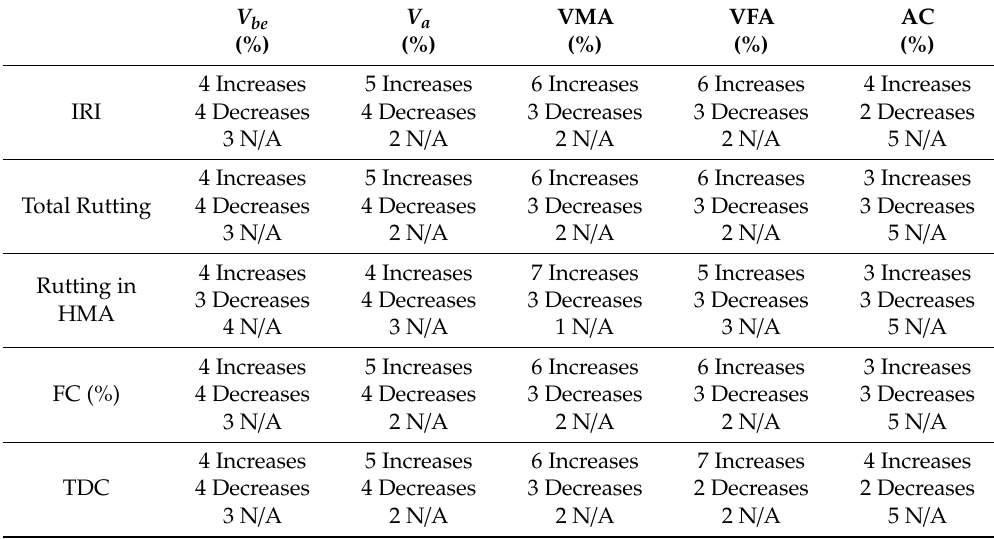
Table 6. Summary of the influence of di ff erent mix